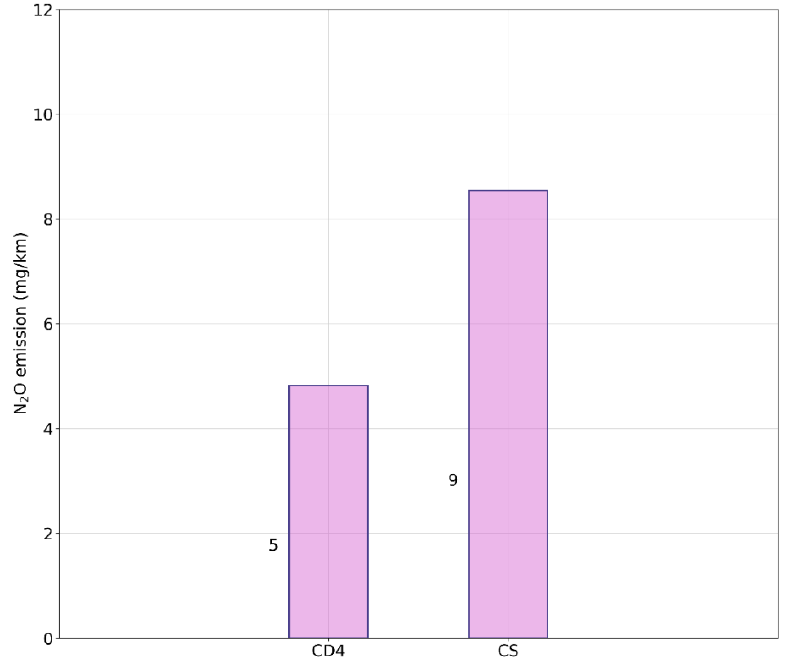
Figure 3. Emissions of N 2 O in WLTC tests at 23 °C. CD4 indicates the 4th cycle in the charge depleting sequence (i.e., the cycle in which the ICE ignited for the first time), started with a battery initial state of charge (SOC) equal to 100%; CS indicates the cold start charge sustaining cycle performed after the battery depleting sequence, i.e., starting with the minimum SOC. See Methods section for additional details.